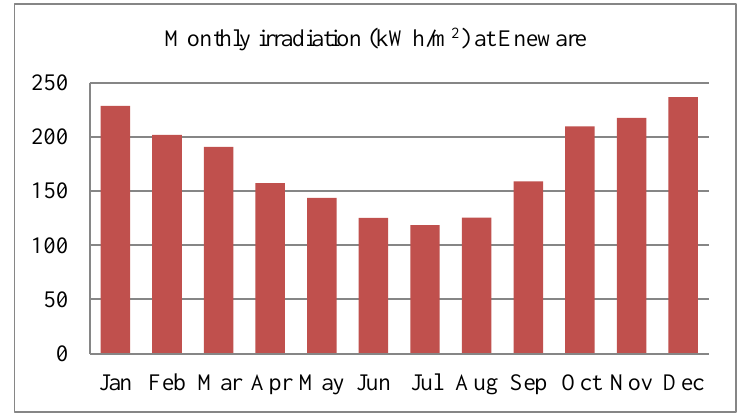
Figure 12. Solar radiation assessment of North Shewa zone at Eneware.